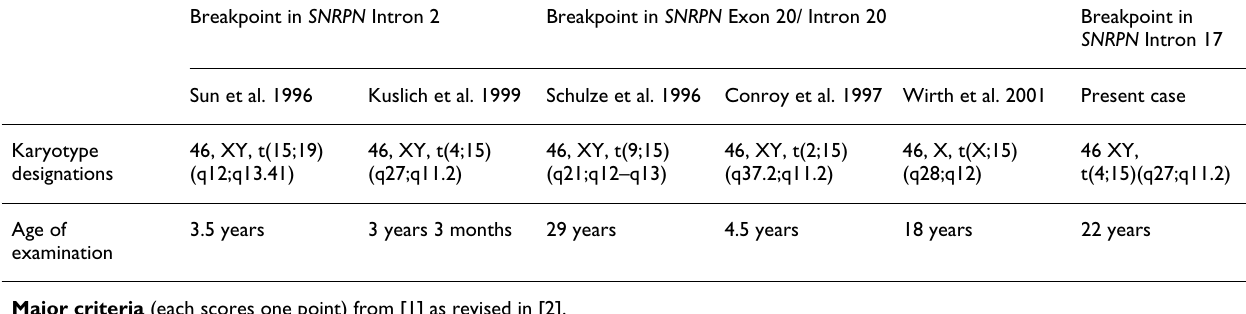
Table 3: Clinical findings associated with paternally-derived de novo reciprocal translocations involving